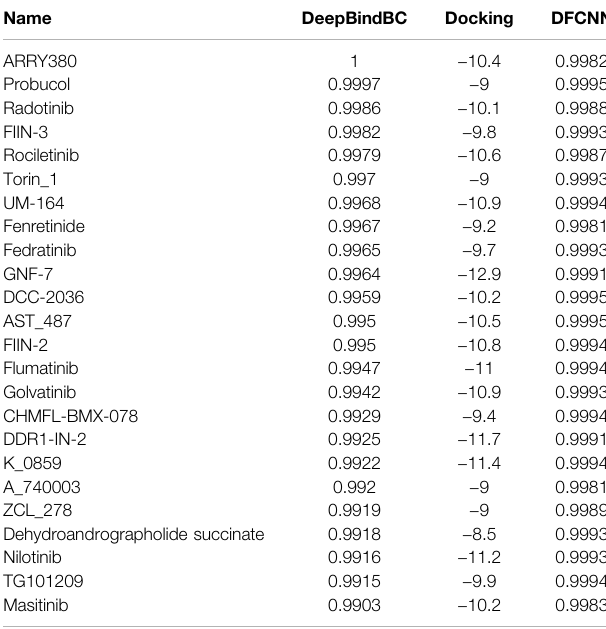
TABLE 2 | The potential inhibitors of TIPE2 from the TargetMol dataset (DeepBindBC > 0.99, Docking < (cid:1) − 8.5, and DFCNN > 0.998, excluding compounds in Table 1 ). The table was ranked by docking score in descending